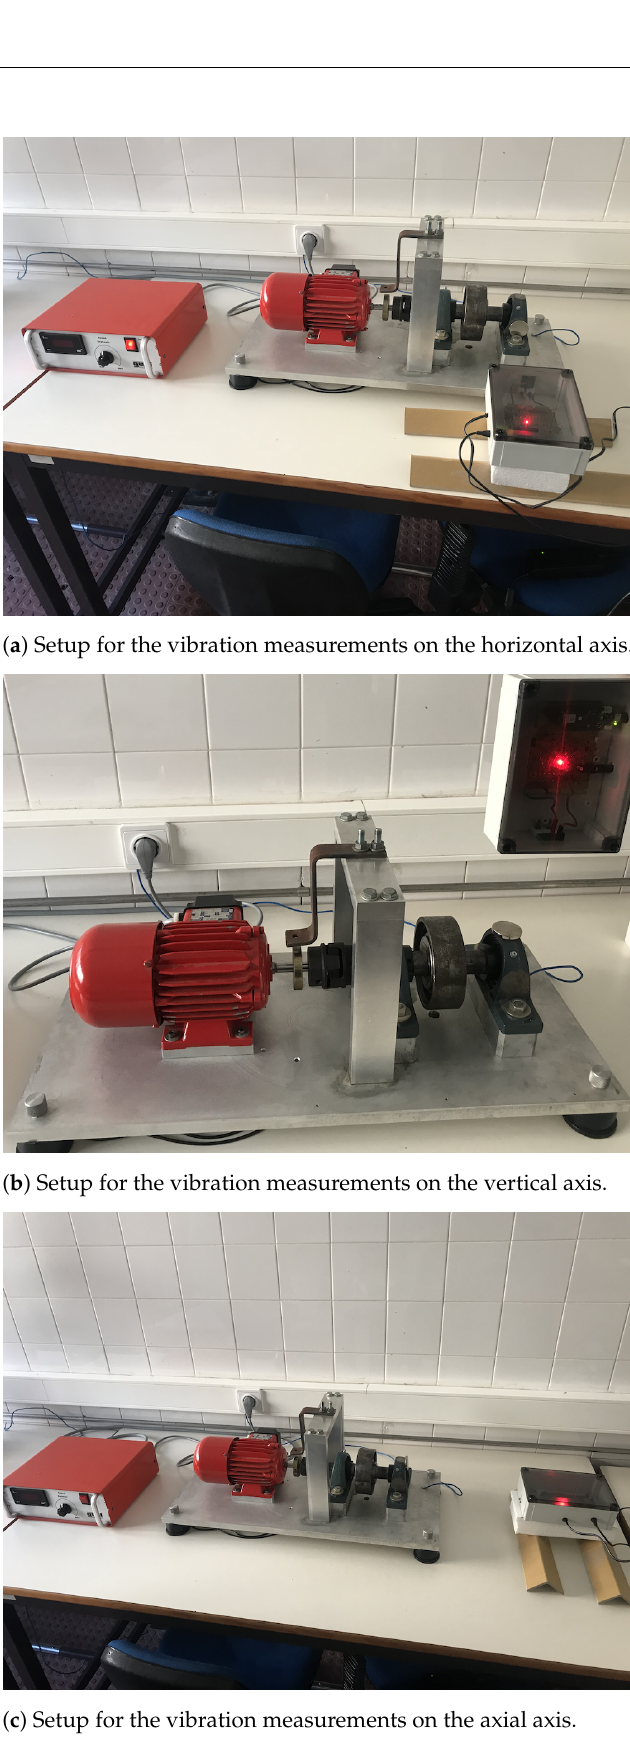
Figure 8. Experimental setup with the magnetoresistive sensor measurement on three